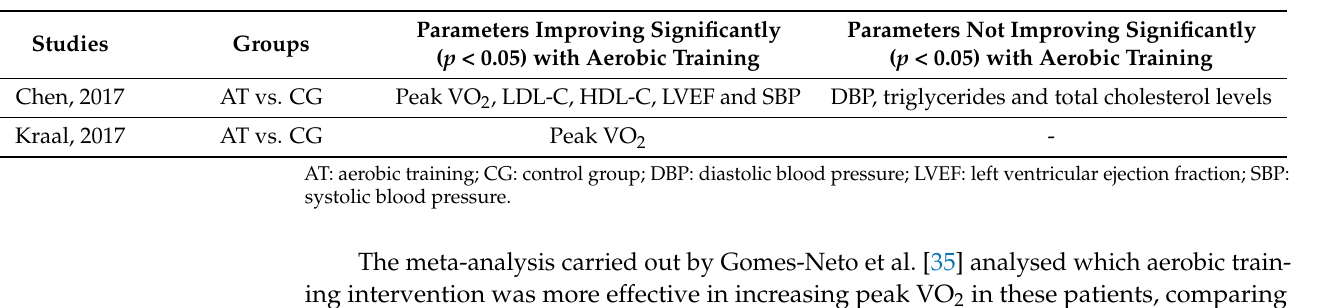
Table 1. Effects of aerobic training in patients with artery coronary